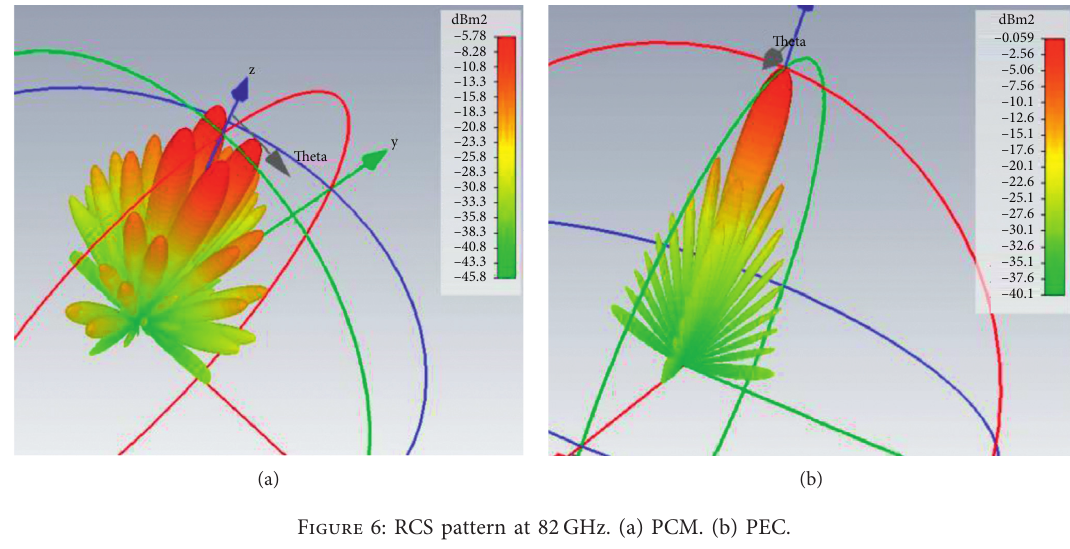
Figure 6: RCS pattern at 82GHz. (a) PCM. (b) PEC.